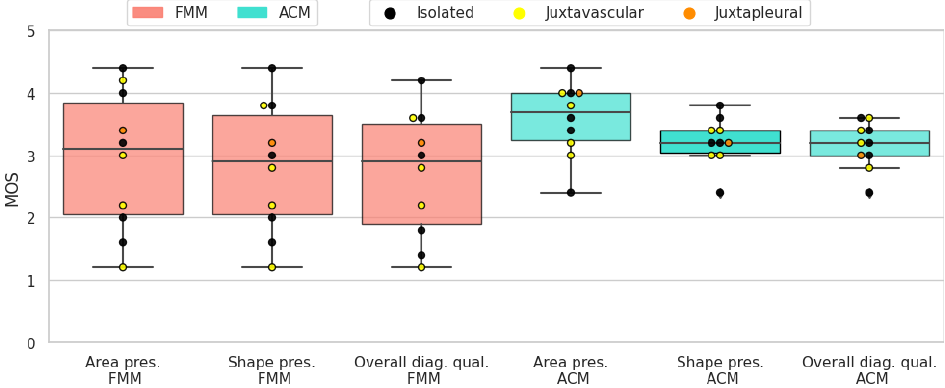
Figure 22. Cavitary nodules’ subjective evaluation results as boxplots, overlayed with the values of individual cases divided into